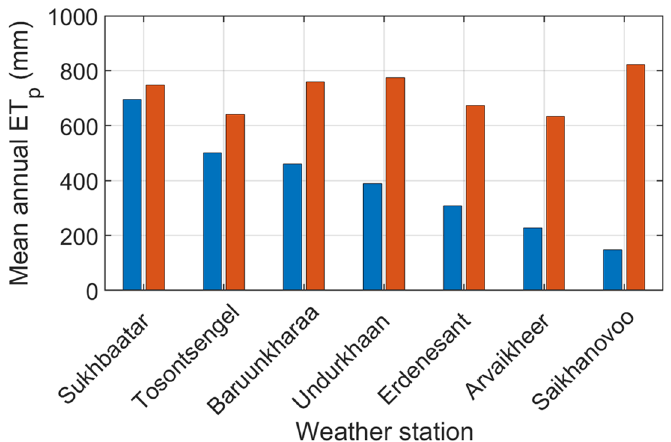
Figure 9. Mean annual sums of ET p based on K c adj (blue bars) and on tabulated K c (orange bars) over six weather stations in Mongolia.